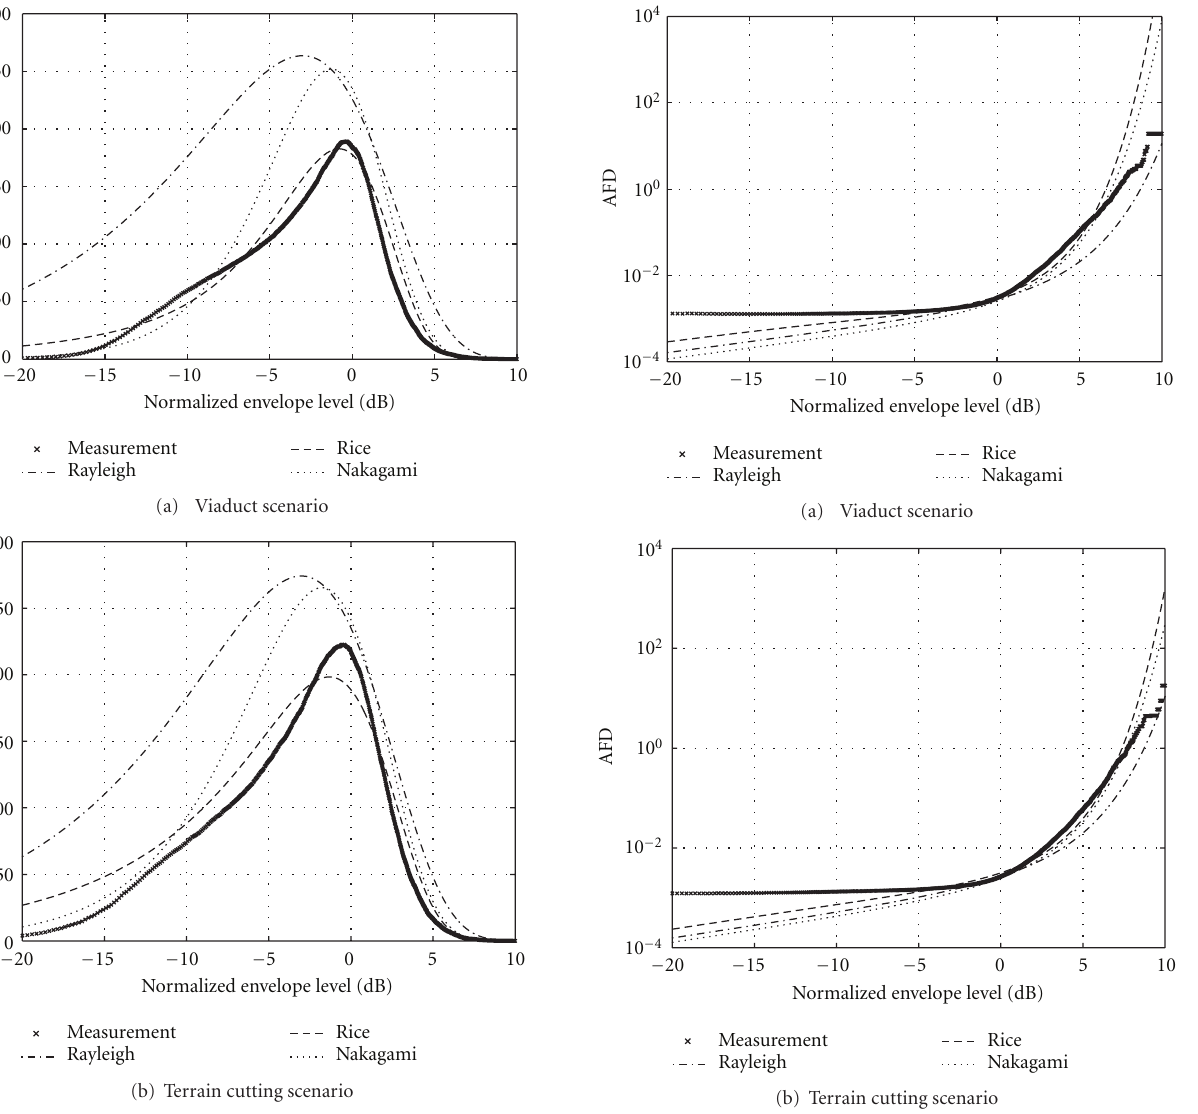
Figure 8: Empirical AFD results in both scenarios for the first measurement, together with the theoretical results of Rayleigh, Rice, and Nakagami fading